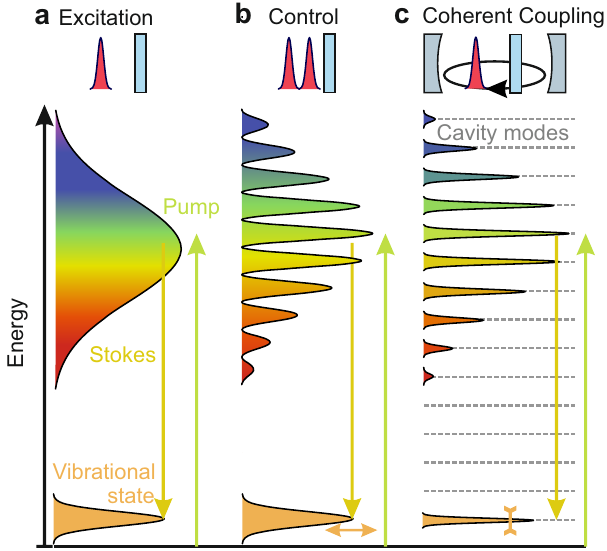
Fig. 4 From excitation to coherent coupling of phonons to phononic wave- packets. a Optical quanta of a single pulse impulsively stimulate a vibrational mode via suitable difference frequencies. b Coherent control of the phonon excitation via a pair of ultrashort solitons. c Inside a short cavity, the mode-spacing of the resonator is matched to the vibrational phonon mode, allowing for feedback and coherent coupling of soliton wave- packets to phonon motion. Resonant pumping induces, e.g., the narrowing of vibrational